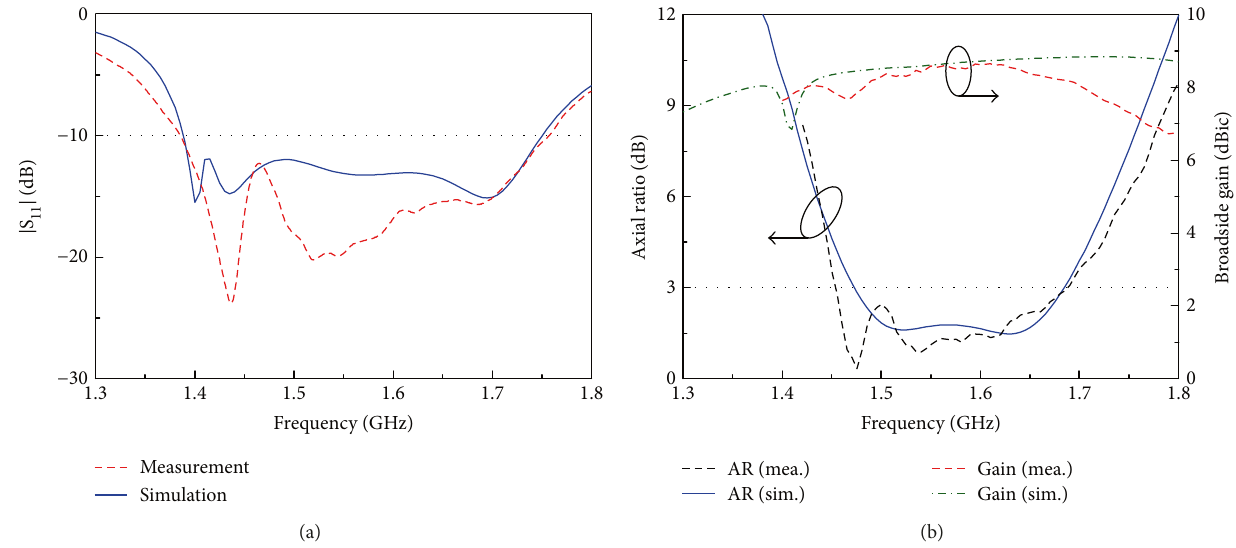
Figure 13: Simulations and measurements of the crossed-dipole antenna loaded with parasitic patches: (a) |S gain values.